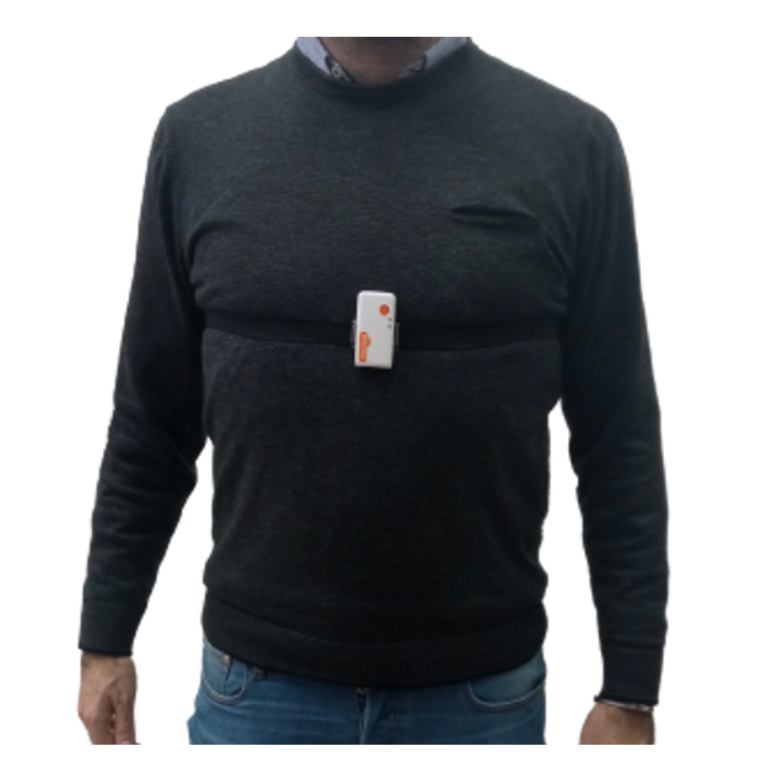
Figure 2. Sensor device